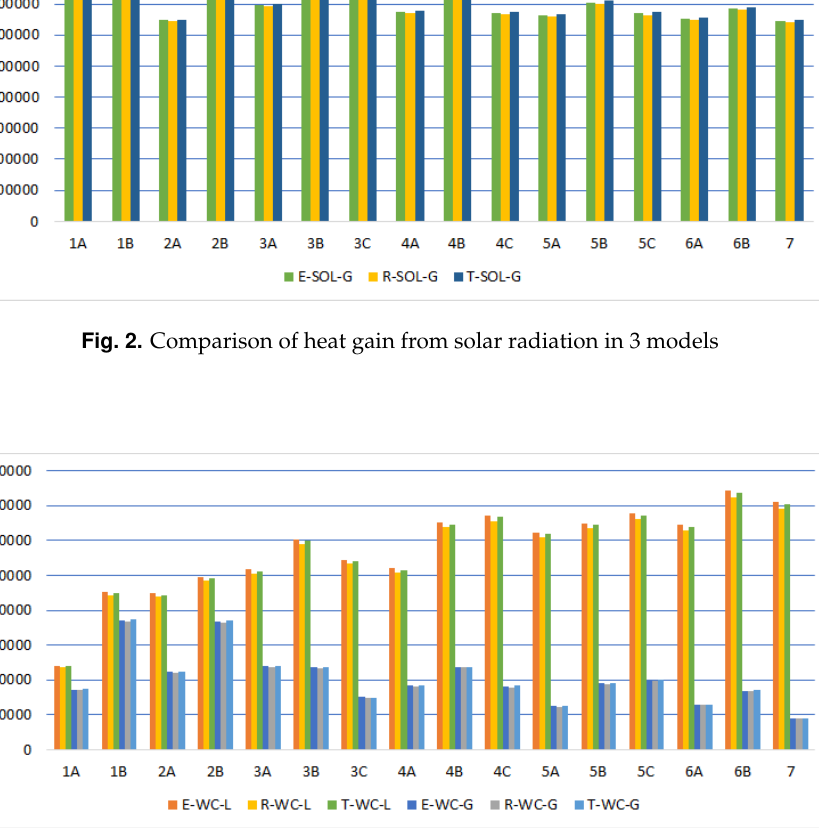
Fig. 3. Comparison of heat gain-losses from wall conduction in 3